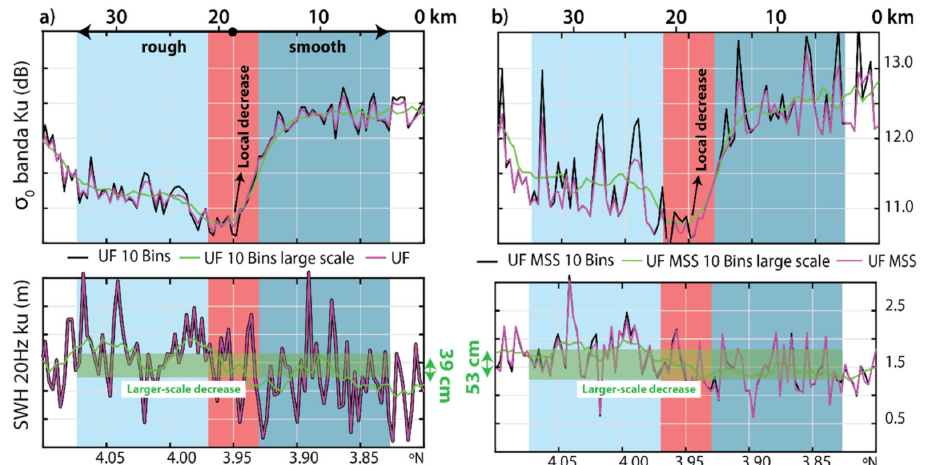
Figure 7. As in Figure 6, but top of ( a , b ) shows along-track NRCSs (i.e., σ 0 ) measured by the SRAL altimeter (in synergy with the OLCI) with the SAR-mode retracking color-coded in ( a ) UFSAR, UFSAR 10 Bins and its large-scale mean and in ( b ) UFSAR MSS, UFSAR MSS 10 Bins and its large-scale mean (using a box running average of 3 km). Bottom plots show SWHs’ large-scale variations of 0.39 m in ( a ) and 0.53 m in ( b ), identified in the green shaded rectangles, when comparing the section in front of the primary ISW with that in the rear for the same